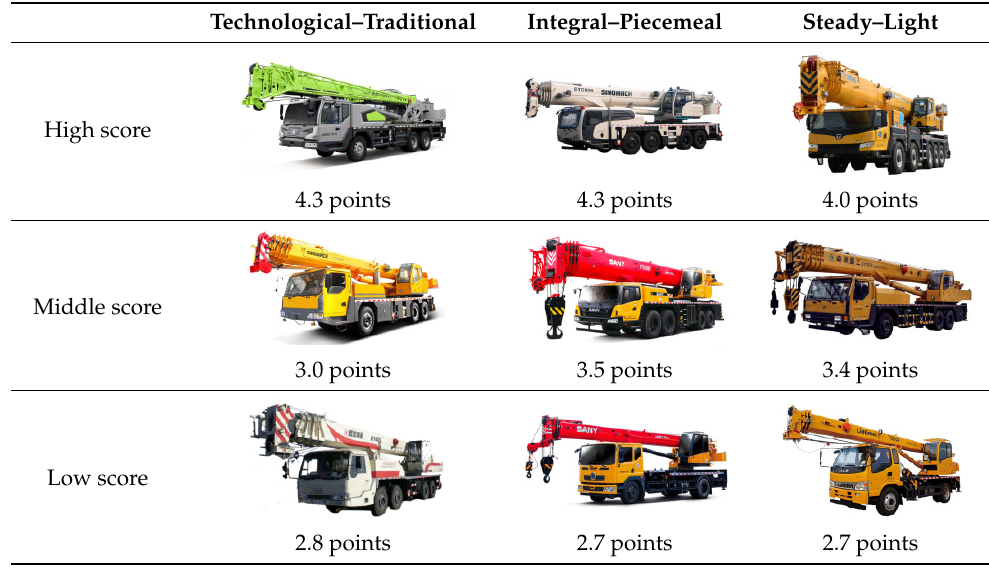
Table 4. Eye-movement experiment samples.